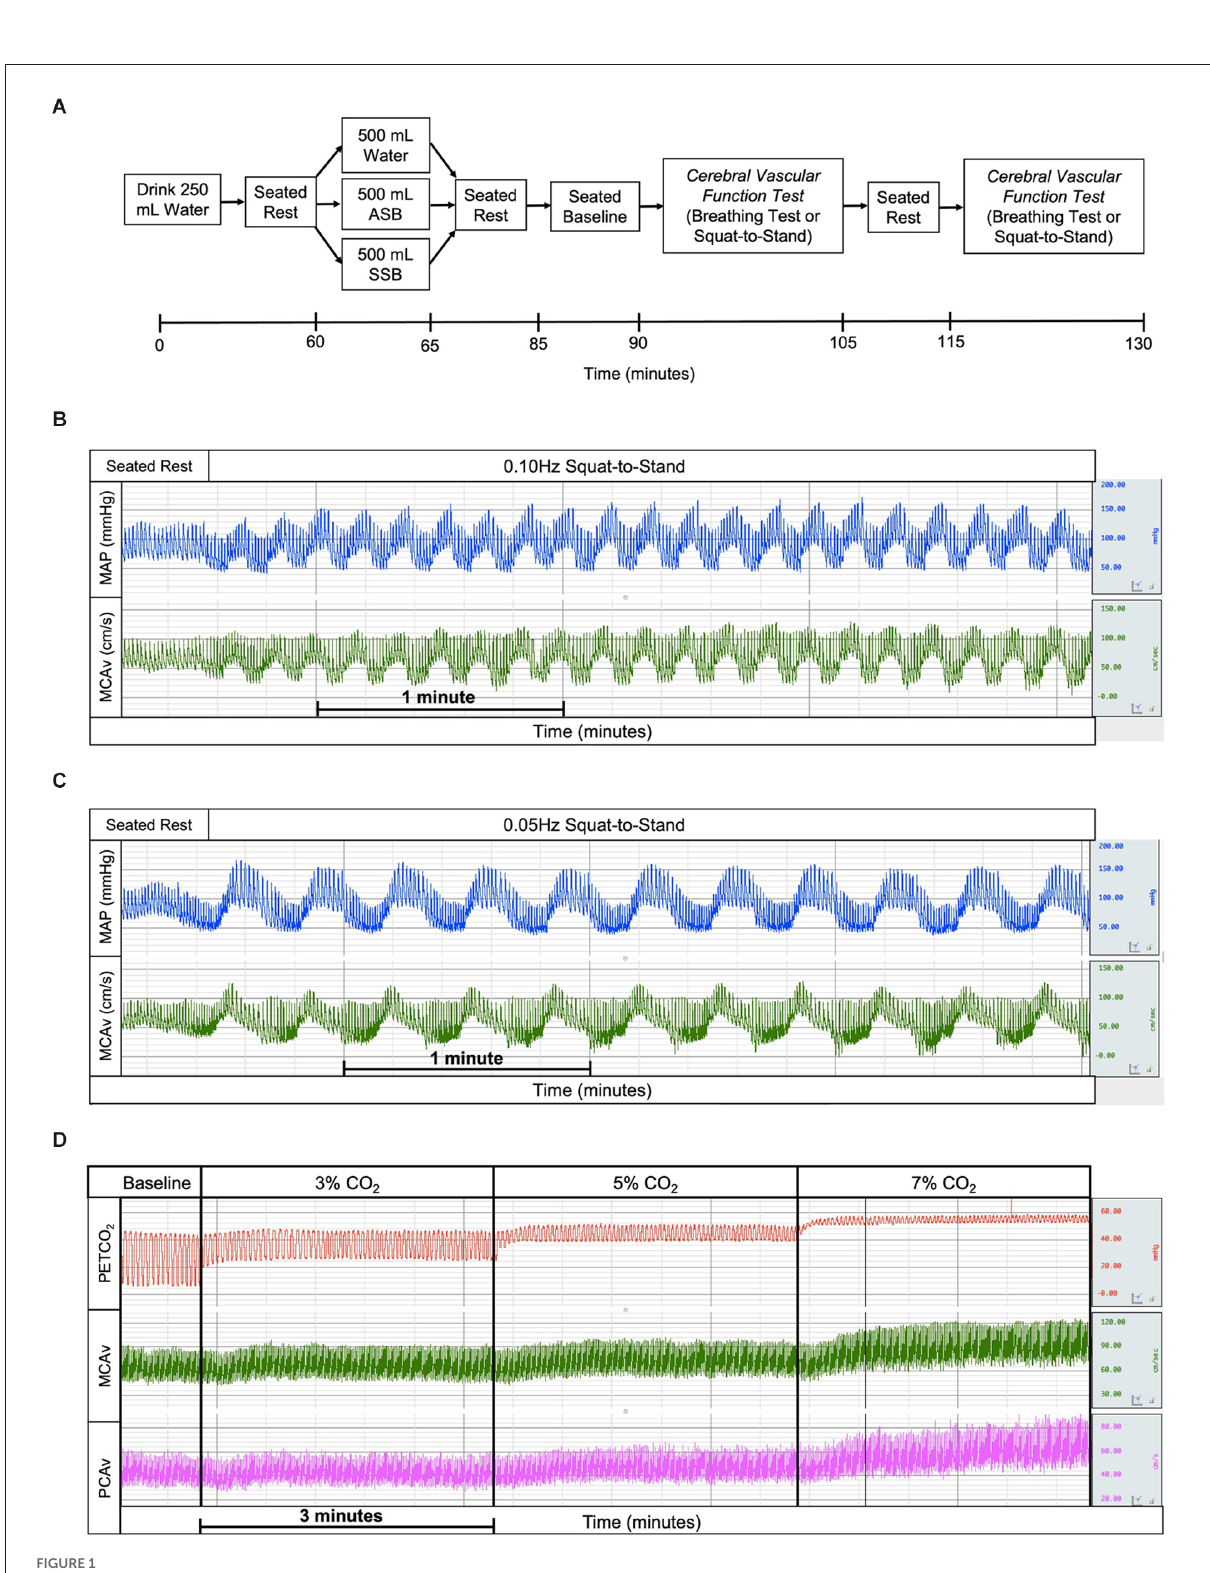
FIGURE1 Experimental study visits timeline (A) where the experimental drinks were randomized and the order of cerebral vascular function tests was randomized and counterbalanced. The example tracings of mean arterial pressure (blue), middle cerebral artery blood velocity (green), end-tidal carbon dioxide (red), and posterior cerebral artery blood velocity (magenta) for squat-to-stand at 0.10 Hz (B) , squat-to-stand at 0.05 Hz (C) , and cerebral vascular reactivity to hypercapnia (D) tests. ASB, artificially-sweetened beverage; SSB, sugar-sweetened